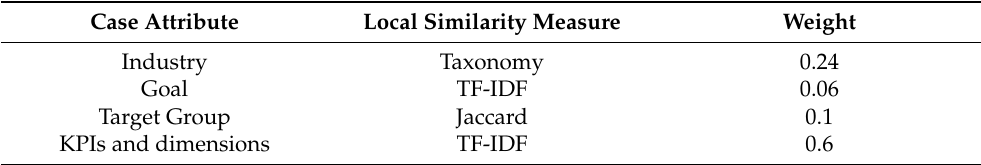
Table 1. Local similarities and weights for CBR